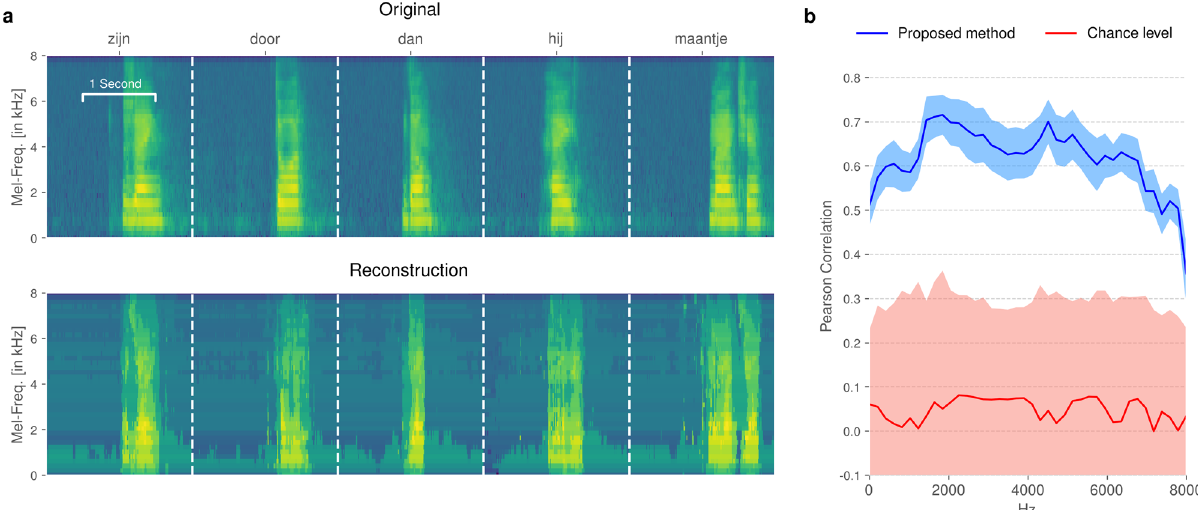
Fig. 3 Decoding performance of the proposed method on the open-loop data from the audible speech experiment. The spectrogram was reconstructed using ten-fold cross-validation. a Visual comparison of original and reconstructed spectrograms. b Correlation coef fi cients across all spectral bins for our approach (blue, n 1 = 10) compared to a randomized baseline (red, n 2 = 100) generated by breaking the temporal alignment between the brain signals and speech recordings. Shaded areas represent standard